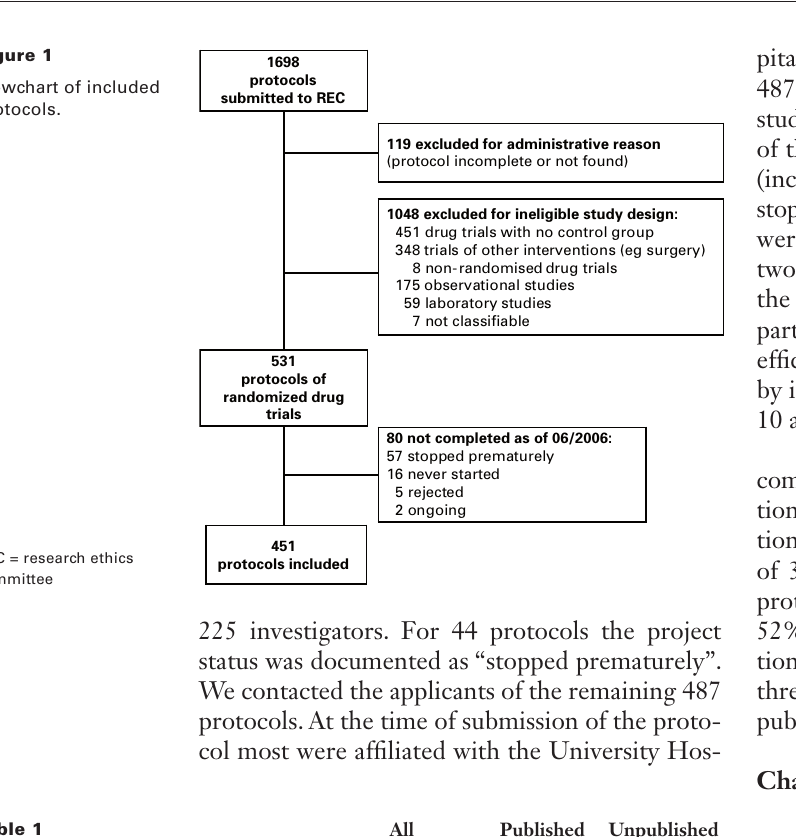
Characteristics of published and unpublished studies.